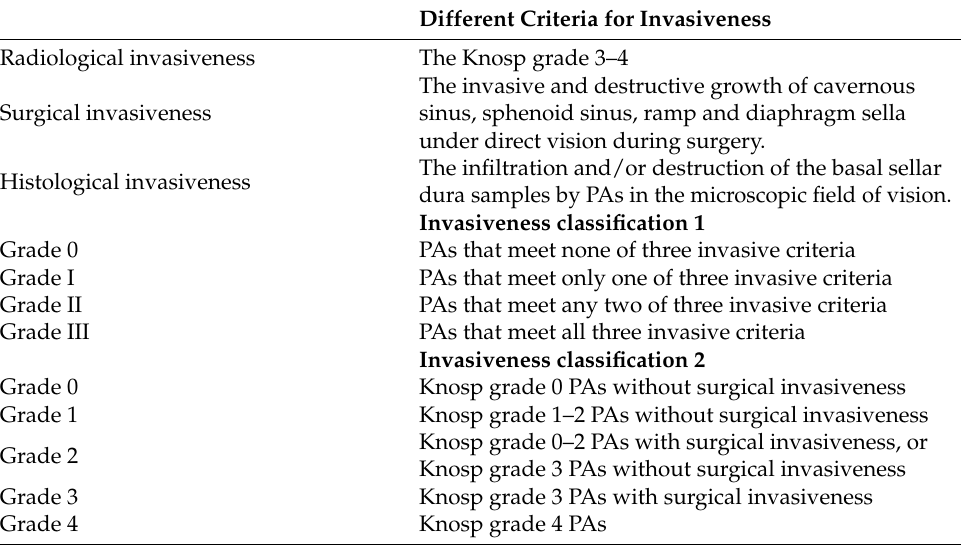
Table 1. Invasiveness classifications of